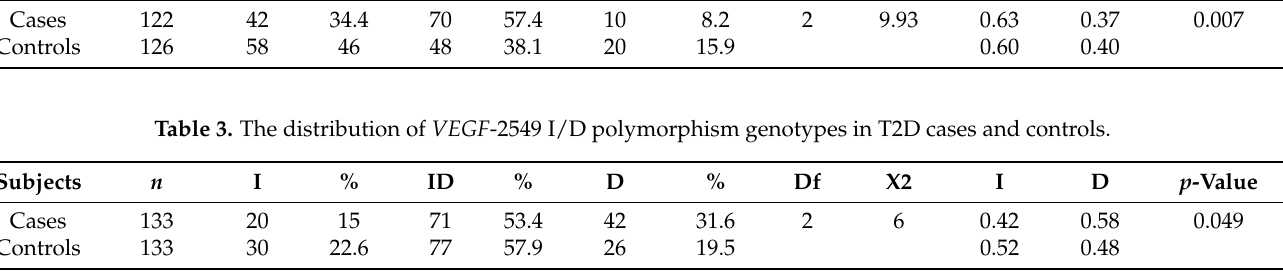
Figure 5. Genotyping of ACE I/D rs4646994 by mutation specific PCR in T2D. Legend: M—100 bp DNA ladder; Homozygous II genotype—P7; Homozygous DD genotype—P2, P3, P4, P5, P8, P10, P11; Heterozygous ID genotype—P1, P6, P9, P12.